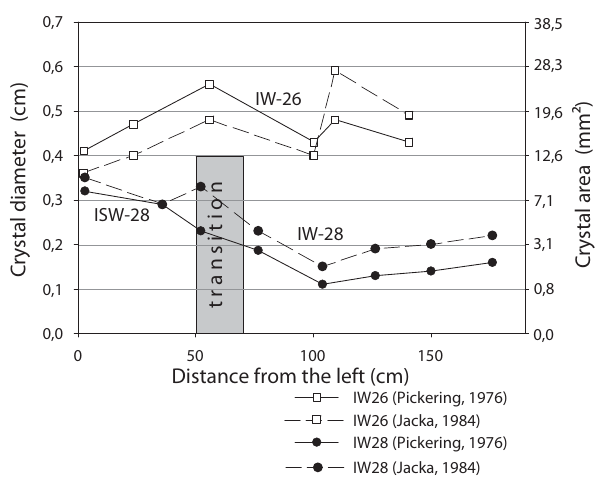
Fig. 5. Crystal size measurements using the two techniques de- scribed in the “sampling and analytical methods”